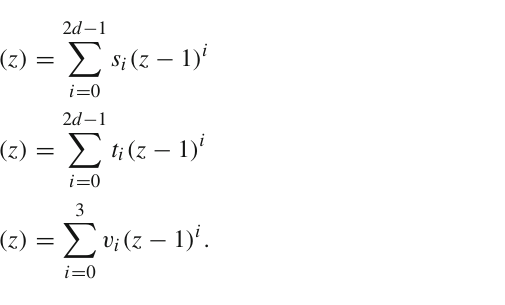
This coefficients S ( z ), T ( z ), V ( z ) are all polynomials